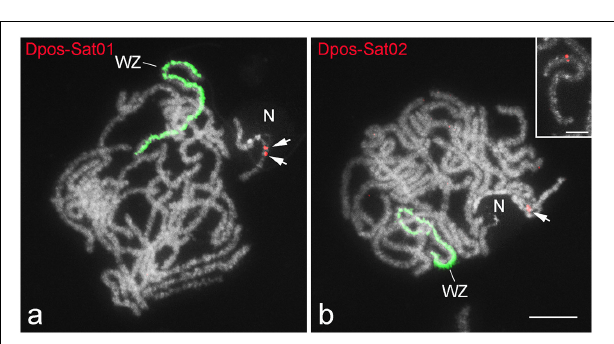
FIGURE 6 | FISH mapping of two satDNAs (red) and W-painting probe (green) in pachytene oocytes of Diatraea postlineella . Chromosomes were counterstained with DAPI. Note that both satDNAs show an autosomal location. Dpos-Sat01 (a) is located on bivalent carrying the nucleolus (N), while Dpos-Sat02 (b) is located on another bivalent. The inset in panel (b) shows in detail the interstitial position of Dpos-Sat02. Bar = 10 µ